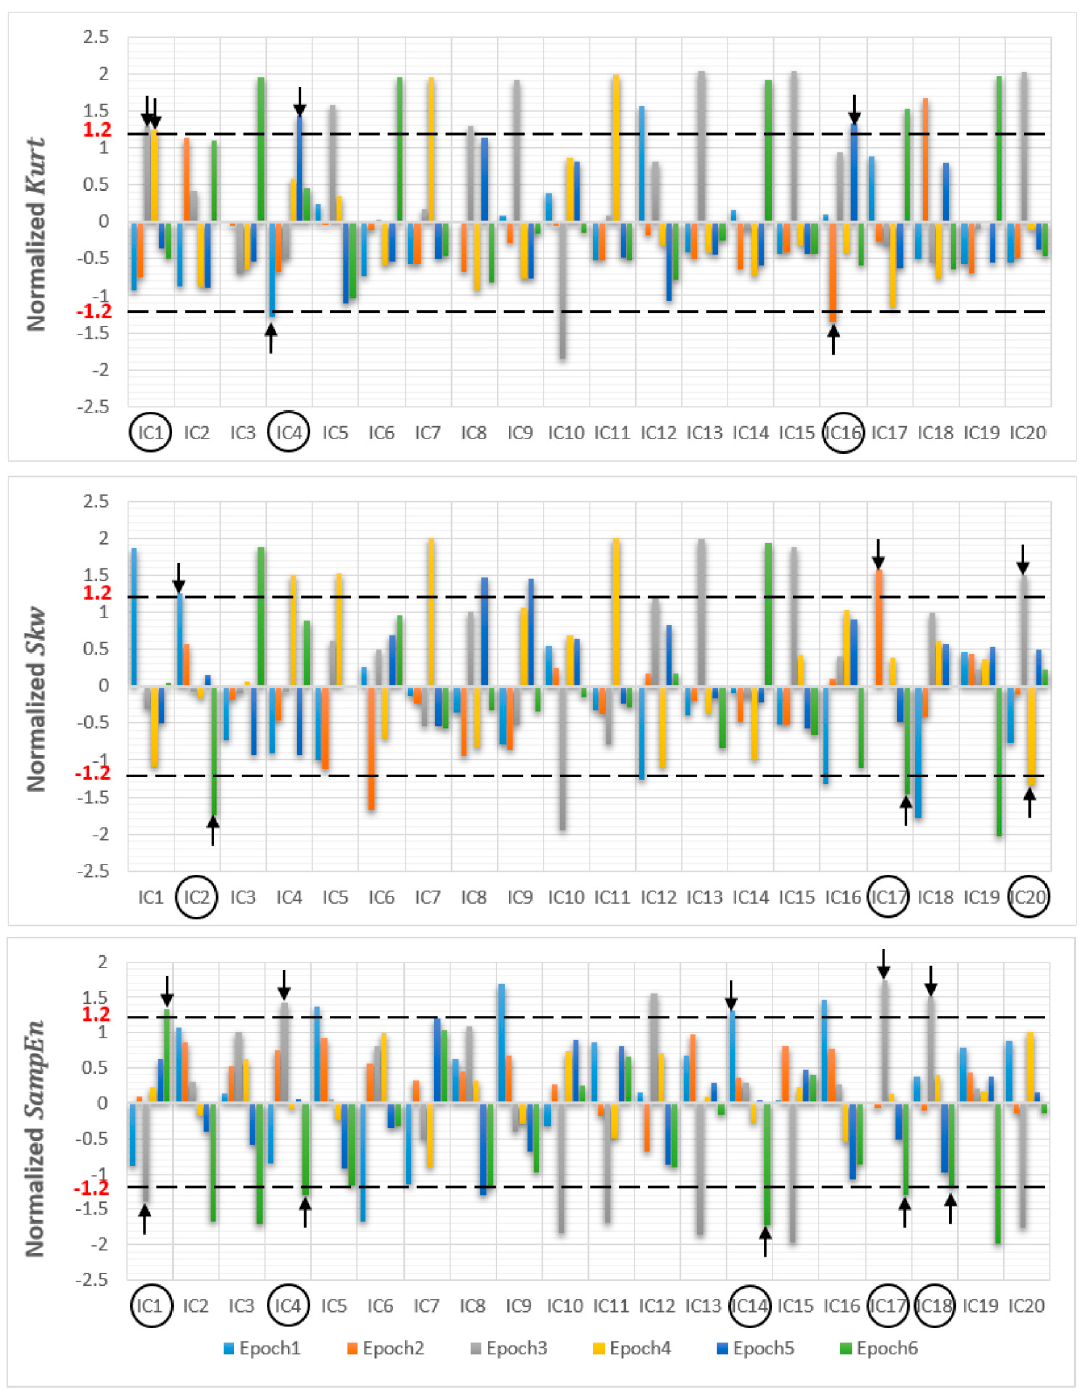
Figure 5. Normalized (kurtosis, skewness and sample entropy) metrics to measure the artifactuality of the Independent components for the first control subject.